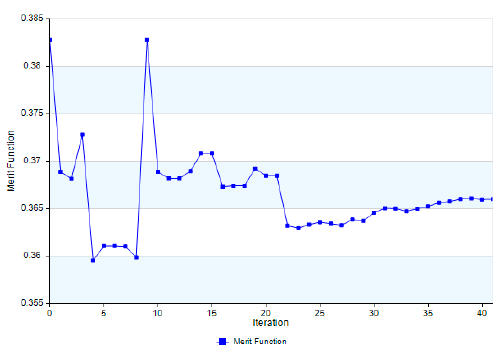
Figure 8. The recorded value curve of merit function in the optimization process.